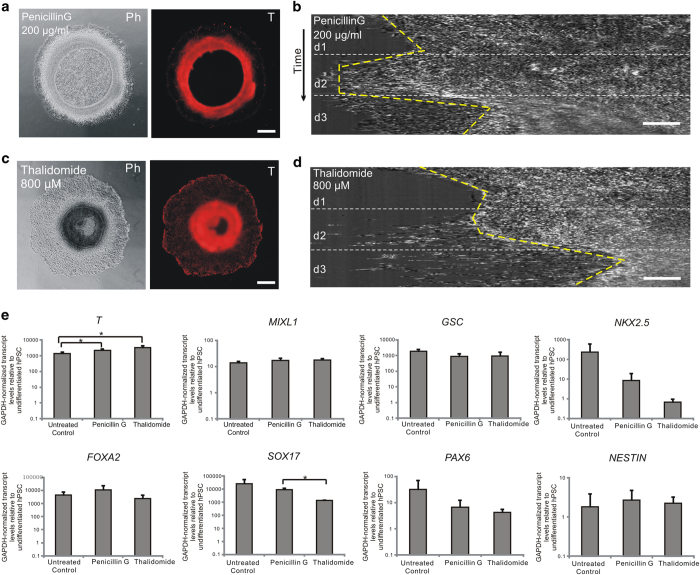
Disruption of annular mesoendoderm pattern by teratogen treatment.(a,c) Phase and T fluorescence images of μP-hPSC colonies under Penicillin G (a) and Thalidomide (c) treatment after 3-day mesoendoderm induction. Scale bar, 200 μm. (b,d) Kymographs of cell movements around colony periphery during 3-day mesoendoderm induction under Penicillin G (b) and Thalidomide (d) treatment. Scale bar, 50 μm. (e) RT-PCR analysis of expression levels of germ layer markers in untreated, Penicillin G-treated and Thalidomide-treated colonies on day 3 relative to undifferentiated hPSCs. Mesoendoderm markers are T, MIXL1 and GSC; mesoderm marker is NKX2.5; definitive endoderm markers are FOXA2 and SOX17; and ectoderm markers are PAX6 and NESTIN. Data are average ± s.d. of three experiments with duplicate samples. *, p < 0.05 in paired t-test.